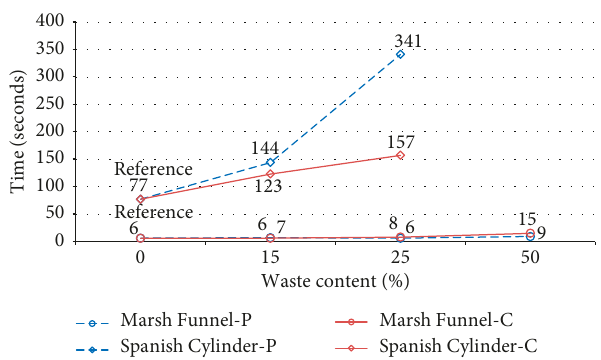
Figure 8: Outflow time results. P: porcelain waste; C: ceramic